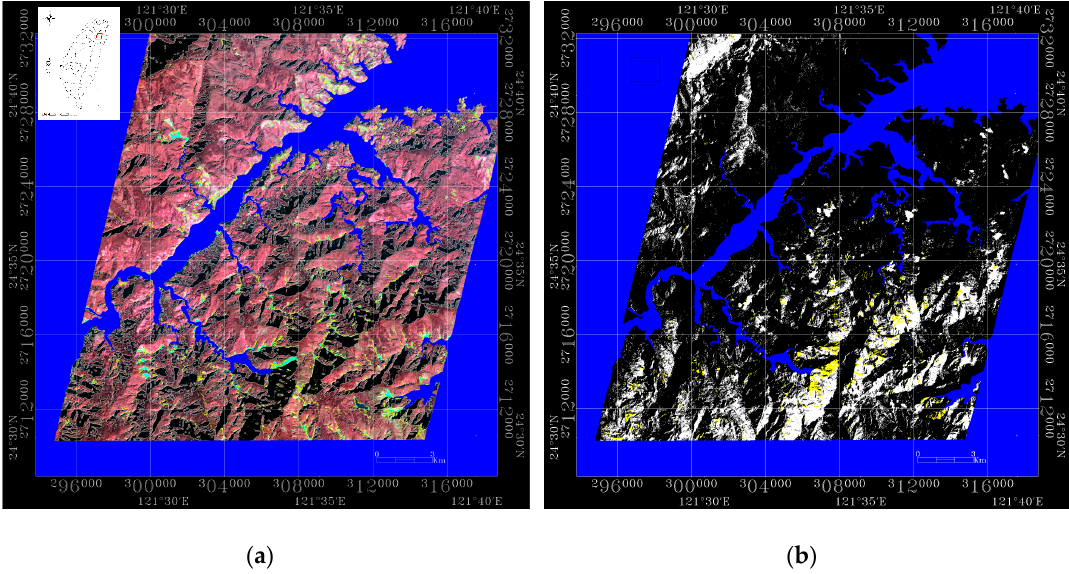
Figure 1. ( a ) A standard false color image of I-Lan taken by Formosat-2 on 24 August 2009. Both the landslide inventory and shadow inventory were prepared using a semiautomatic expert system [24] and masked as yellow and white polylines, respectively. ( b ) The union of all landslide inventories (yellow polygons) and shadow inventories (white polygons) derived from the annual Formosat-2 imagery (2005–2016). The river channel and those regions outside the study area are annotated in blue. The area ratios of landslide inventory and shadow inventory are 3.9% and 34.1%, respectively.